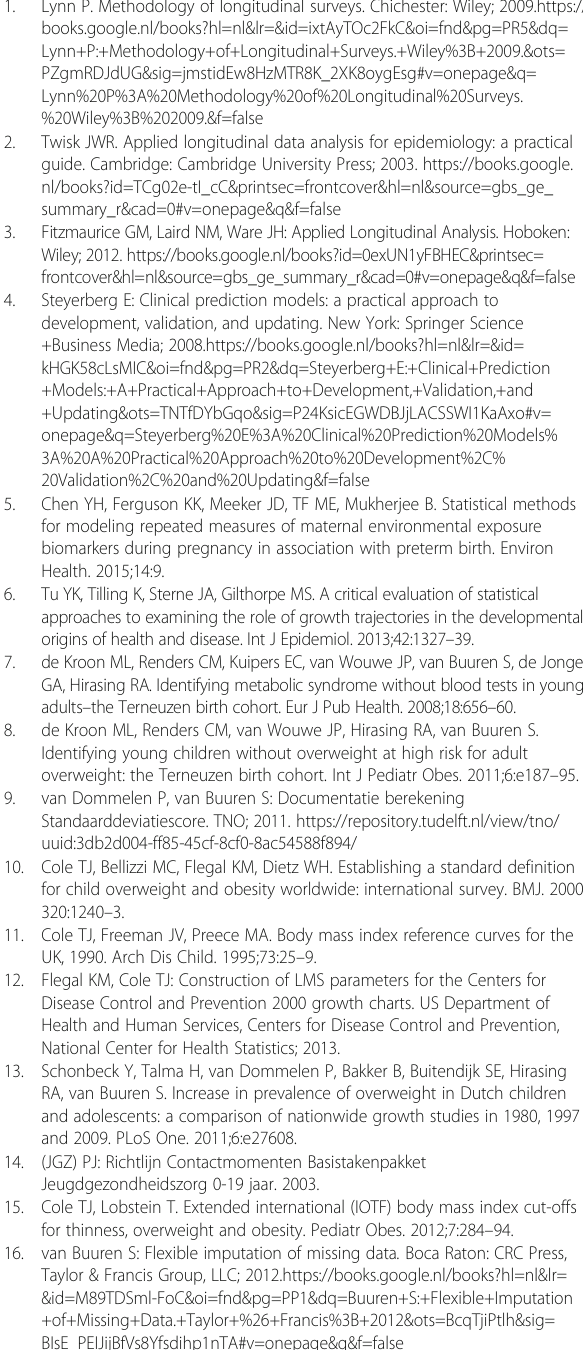
Abbreviations AUC: Area under the curve; BMI: Body mass index; CHC: Child Health Care; IOTF: International Obesity Task Force; SDS: Standard deviation